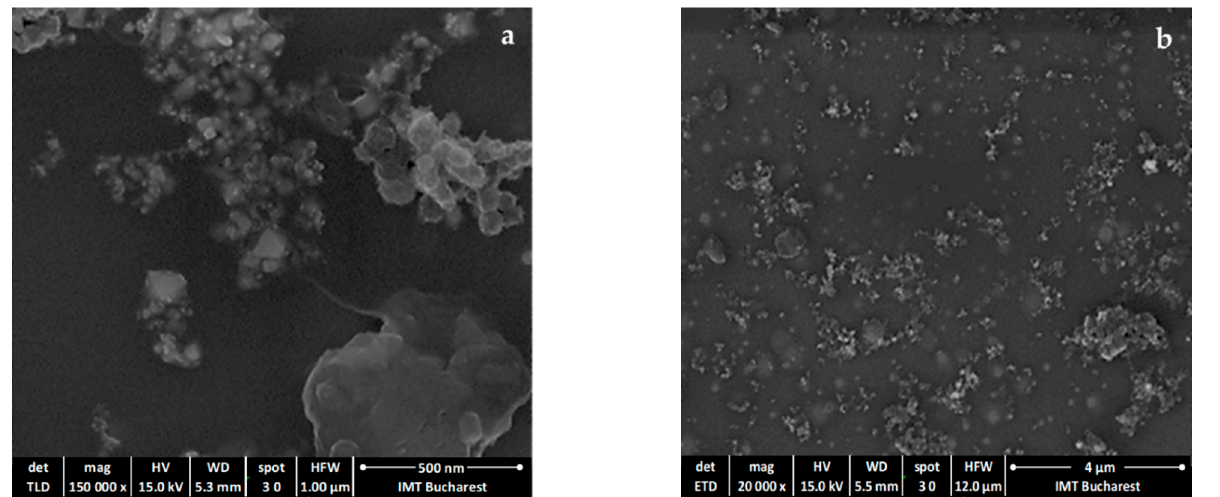
Figure 4. Scanning electron micrographs of the CNHox/GO/SnO 2 /PVP = 0.75/0.75/1/1 w/w / w/w ratio: ( a ) magnification 150,000; ( b ) magnification 20,000.